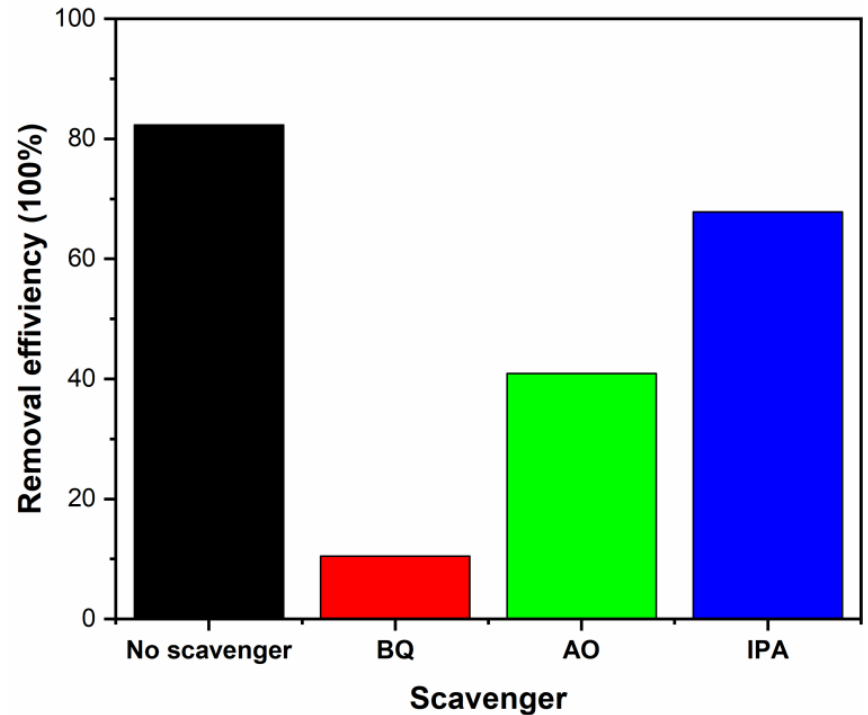
Figure 9. Degradation degrees of Ag@SnO 2 /TiO 2 with different capture agents.